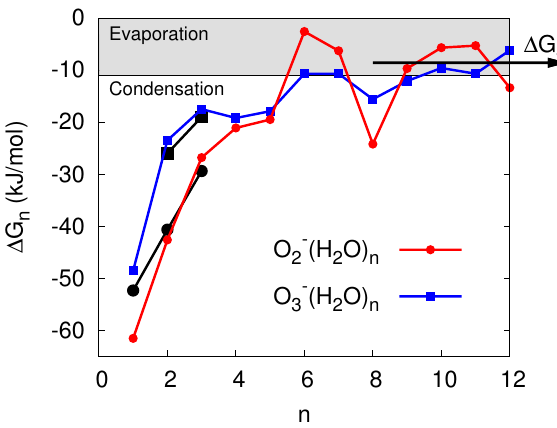
Fig. 1. 1 G for Reactions (R1) and (R2). Regimes implying con- densation and evaporation are indicated for 298K and 50% relative humidity. 1G ∞ denotes the value of hydrated H 2 O. Black spheres and squares are experimental data from Arshadi and Kebarle (1970) and Fehsenfeld and Ferguson (1974),